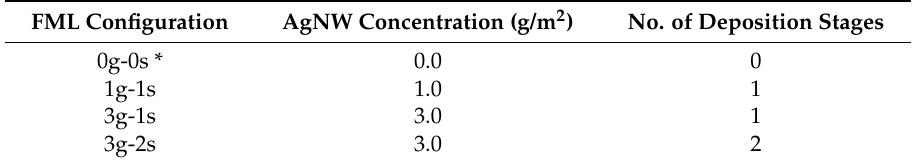
Figure 1. ( a ) Single-stage and ( b ) two-stage silver nanowire deposition. [AgNW] represents the concentration of nanowires deposited at each stage. Table 1. Fibre Metal Laminate (FML) variants investigated for mode I fracture toughness properties.